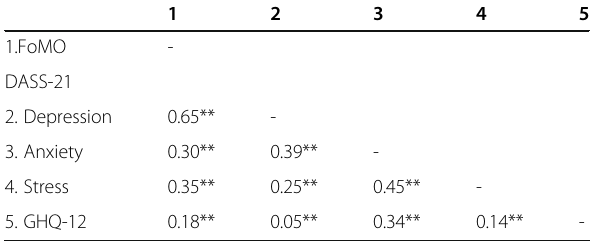
Table 4 Correlation matrix of the study